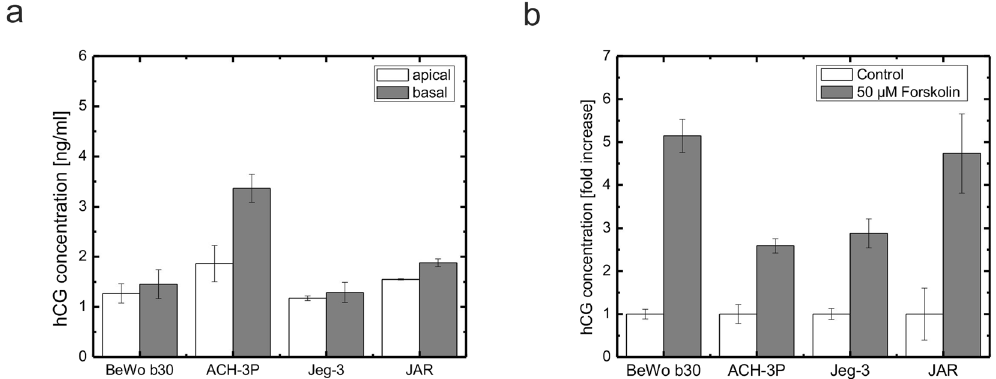
Figure 4. Secretion of hCG of four different placental cell lines. ( a ) Apical and basal secretion of hCG of BeWo, ACH-3P, Jeg-3 and JAR placental transwell cultures at day 5 post seeding (n = 3). ( b ) Response to forskolin treatment of hCG secretion of trophoblast derived cell lines BeWo, ACH-3P, Jeg-3 and JAR placental cell lines in 24-well microtiter plates at day 7 post seeding. Cells were stimulated with 50 µ M forskolin at day 5. Data points are mean values ± SD for n = 3 . Data is normalized to cell numbers and expressed as fold increase of the untreated